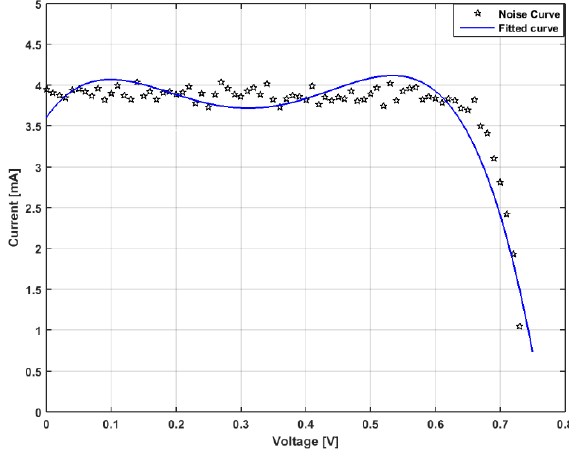
Figure 13 : I-V curve with noise fitted